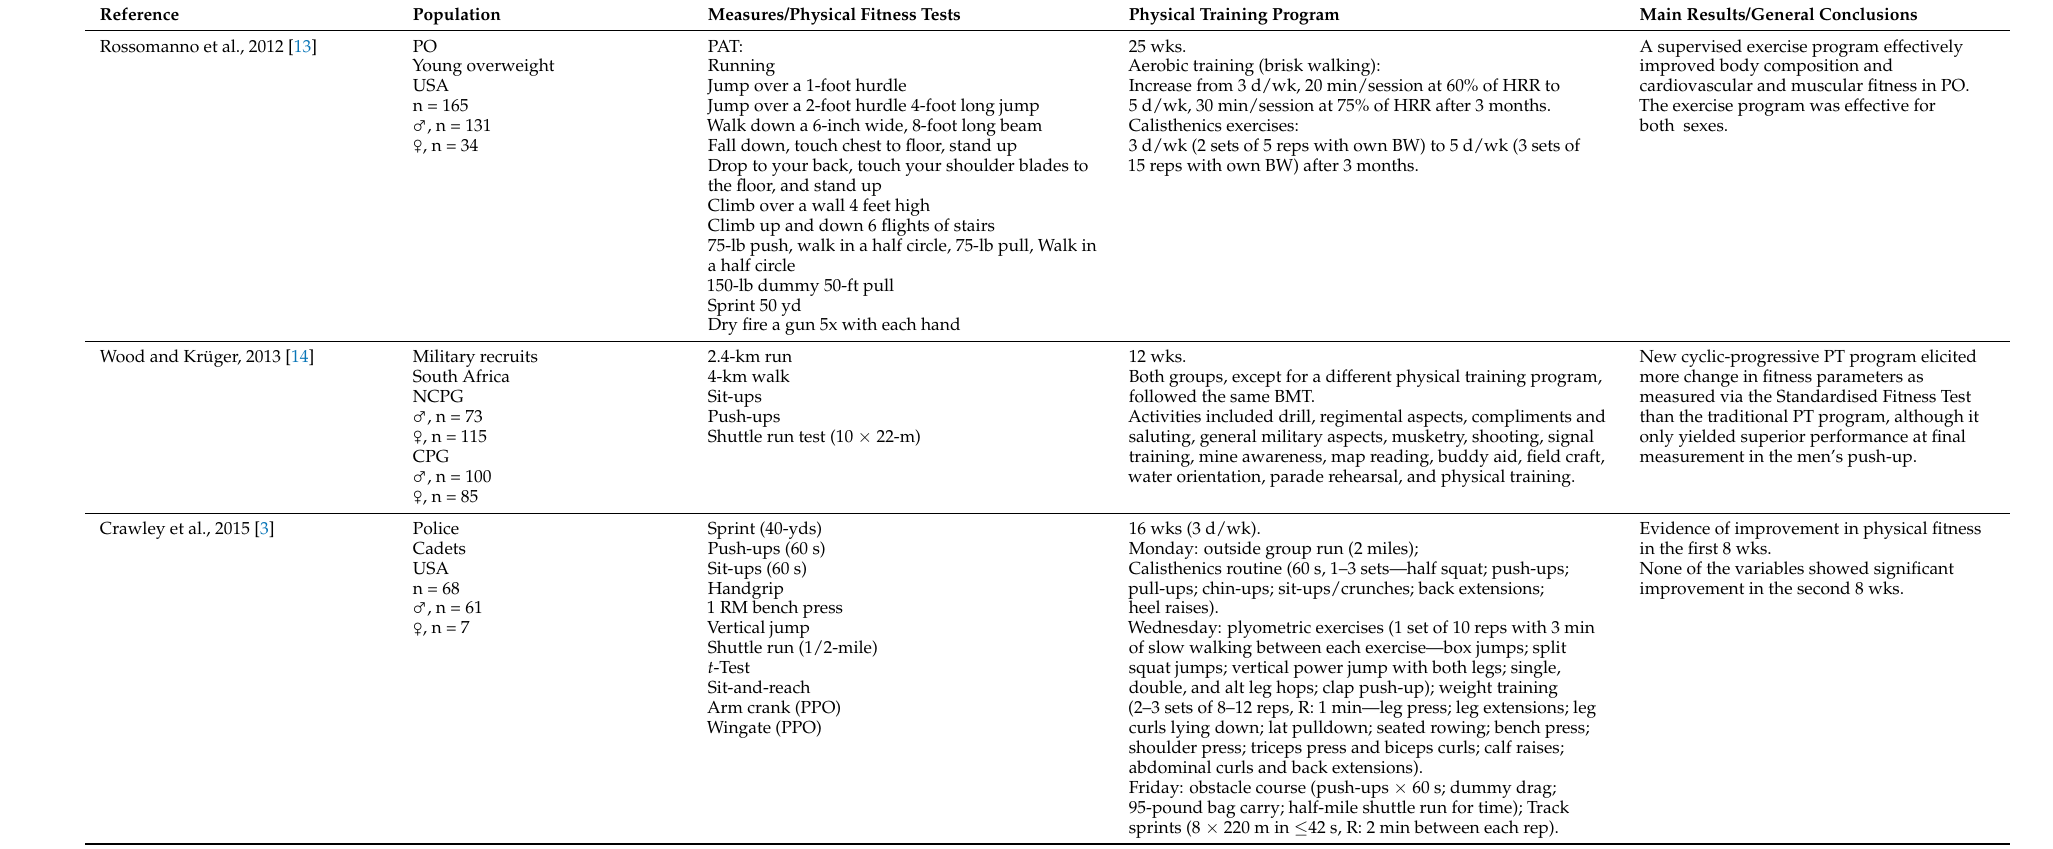
Table 3. The data extraction table, including physical fitness tests and training programs, with key